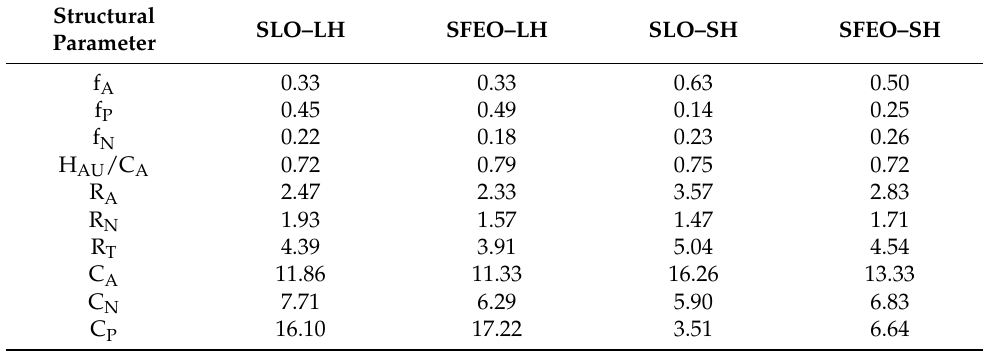
Table 4. Average molecular structure parameters of SLO and SFEO obtained by H 1 -NMR.